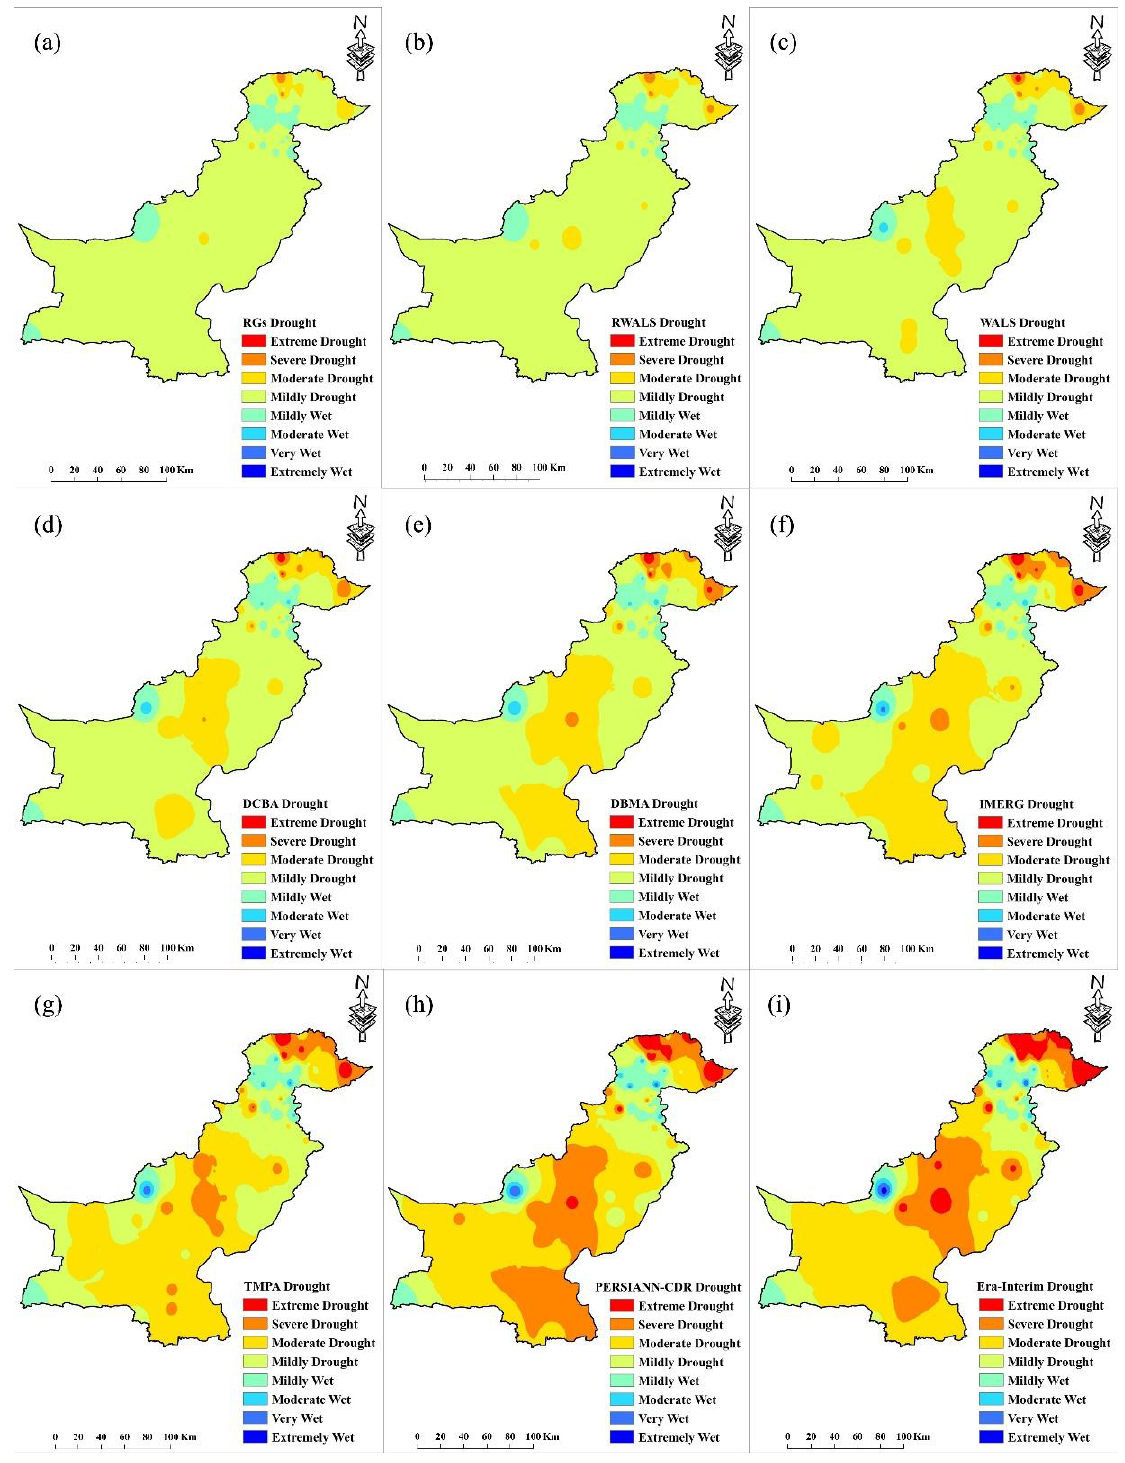
Figure 6. Spatial distribution drought (SPI-3) across Pakistan during post-monsoon season in the representative drought year (2008), ( a ) RGs, ( b ) RWALS-MSPD, ( c ) WALS-MSPD, ( d ) DCBA-MSPD, ( e ) DBMA-MSPD, ( f ) IMERG, ( g ) TMPA, ( h ) PERSIANN-CDR, and ( i ) ERA-Interim. The drought severity in glacial region is ranging from mildly drought (RGs, RWALS, and WALS) to severe drought (PERSIANN-CDR and ERA-Interim). Drought in the glacial region is showing a decreasing trend from the extreme north of glacial region toward the extreme south. The regional average SPI-3 values for RGs, RWALS, WALS,